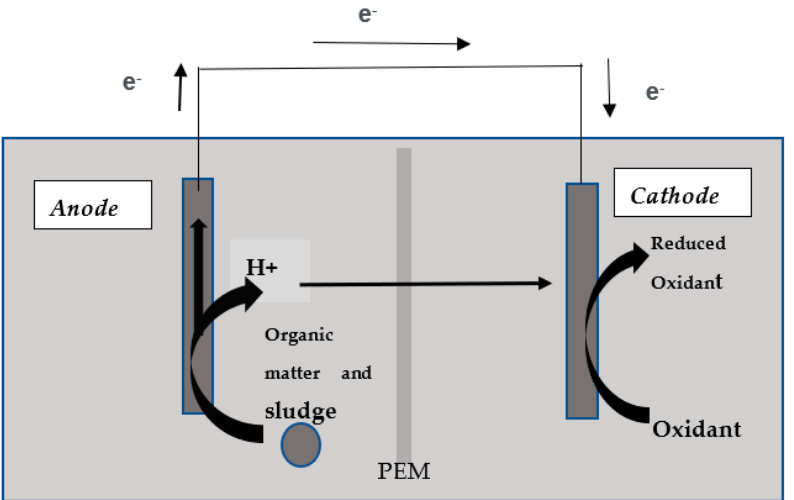
Figure 1. Various parts of the MFC: anode chamber, cathode chamber, and proton-exchange mem- brane (PEM). The arrows show the direction of the flow of electrons within the MFC; the cathode contains buffer and KMnO 4 as an electron acceptor. The whole system was kept in a water bath at 35